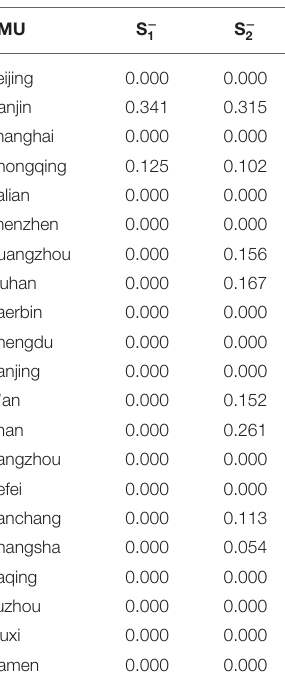
TABLE 1 | Analysis